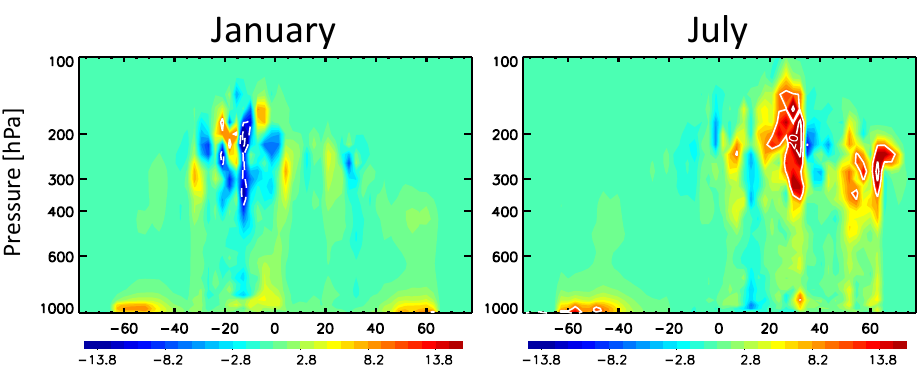
Fig. 13. Latitude-pressure cross-section of the LNO x source differences between the data assimilations with and without (with minus without) the cloud-covered OMI NO 2 observations (in pptvday − 1 ) for January and July in 2007. The increases and decreases in the source due to assimilation of the cloud-covered observations correspond to positive and negative values represented by red and blue, respectively.